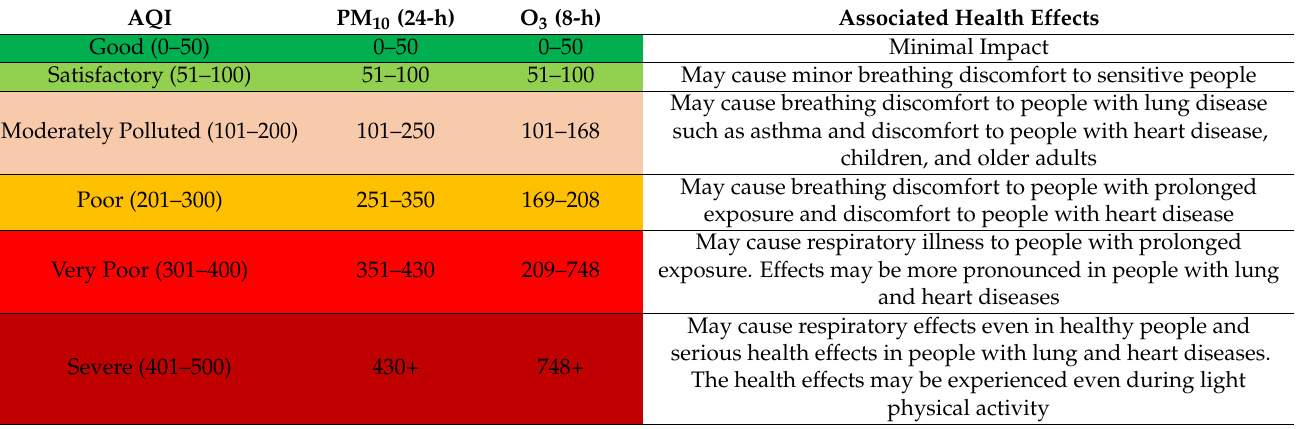
Figure 8. Air quality index of PM 10 for original and proposed emission scenarios. Table 3. Concentration ranges corresponding to AQI categories and their associated health effects for PM 10 and ozone (Source: CPCB